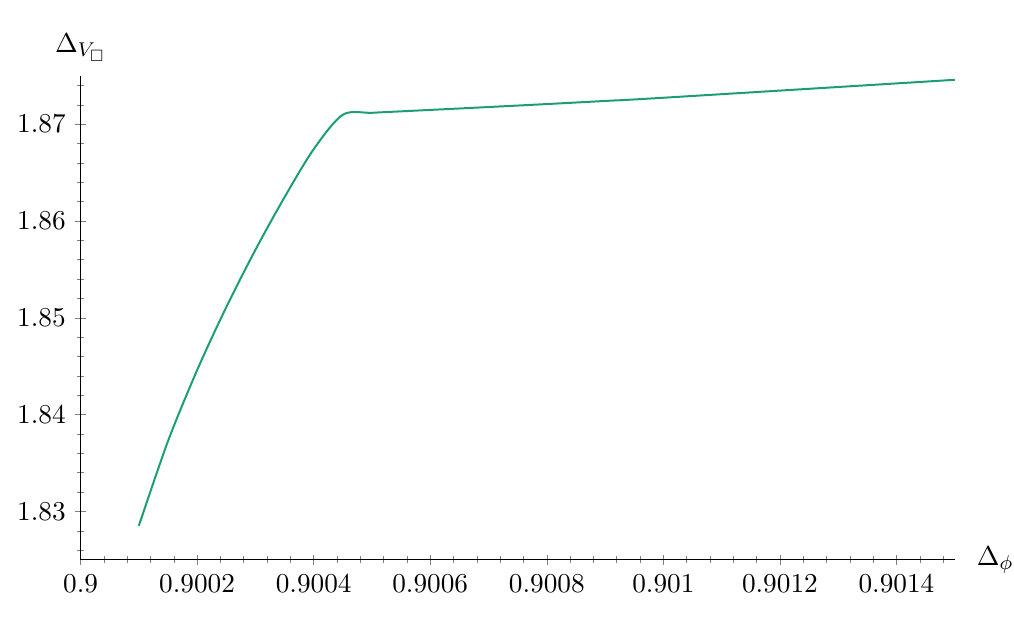
Figure 16 . Upper bound on the dimension of the (cid:12)rst V + a function of the dimension of (cid:30) in the C 3 theory in d = 3 : 8.